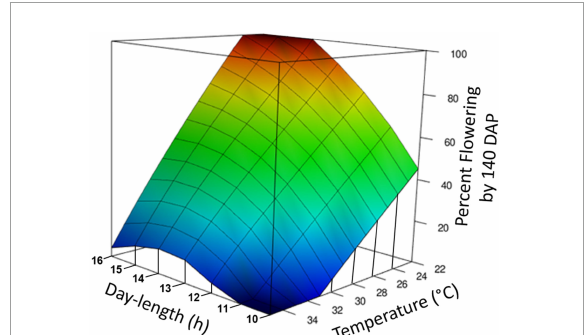
FIGURE3 Graphical representation of photoperiod and temperature effect on percentage of plants induced to flower. The response surface was calculated by loess regression based on data from experiments Photoperiod 1, Photoperiod 2, Temperature, and Photoperiod × Temperature. All experiments were standardized by using the data for percent forking at 140 days after planting (DAP) and genotypes TMS98I0002, Nase3, and TMEB419. Day-time temperatures are shown.